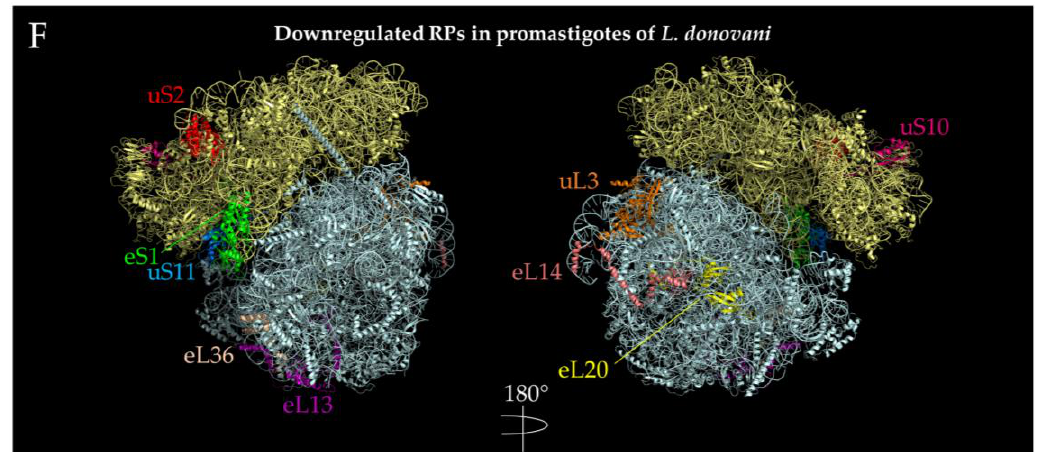
Figure 6. Localization of ribosomal proteins developmentally regulated in Leishmania spp. PDB 5T2A [121] ribosome structures were used to visualize the ribosomal proteins using PyMOL [110]. The SSU is indicated by pale yellow, while the LSU is indicated by pale cyan. Regulated proteins are highlighted and denoted next to the protein with their respective colors. ( A ) Upregulated ribosomal proteins in the transition from procyclic to metacyclic promastigotes in Leishmania major . LSU α , part of the 26S rRNA, was hidden to better illustrate the location of eL32. ( B ) Downregulated ribosomal proteins in the transition from procyclic to metacyclic promastigotes in Leishmania major . P2 is not pictured as PDB 5T2A does not contain a solved structure of this protein. ( C ). Downregulated ribosomal proteins in the transition from metacyclic promastigote to amastigote-like forms in L. tropica . Both the +y and -y directions for this stage of development were depicted. ( D ) Upregulated ribosomal proteins in the transition from metacyclic promastigotes to amastigote-like forms in L. tropica . The view of only one side of the ribosome is shown, which is 180 degrees from C. ( E ) Upregulated ribosomal proteins in the transition from amastigotes to promastigotes in L. donovani . The view of only one side of the ribosome is shown containing all three ribosomal proteins. P2 is not pictured as PDB 5T2A does not contain a solved structure of this protein. ( F ) Downregulated ribosomal proteins in the transition from amastigotes to promastigotes L. donovani . The +y and – y ribosome directions are indicated by a 180 degree turn. eS31 was not depicted since 5T2A does not have that coordinate.